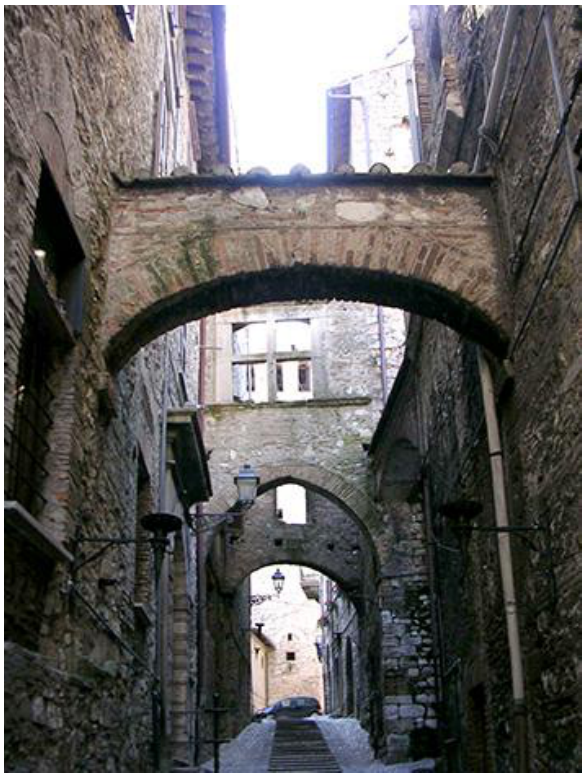
Figure 3. Historical centre of Narni (Terni):